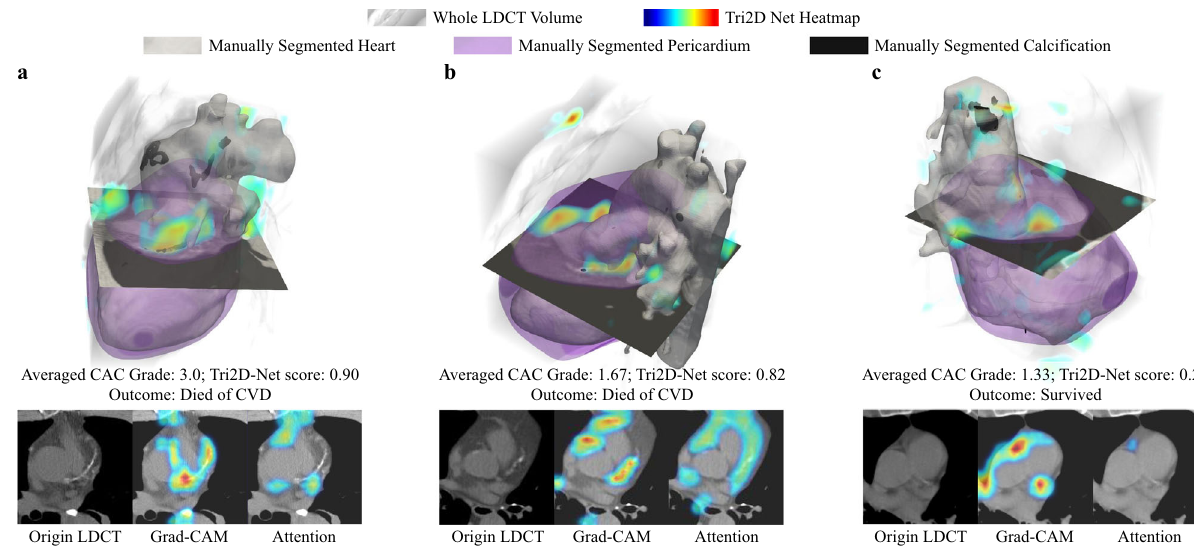
Fig. 5 Visualizations of the features learned by the Tri2D-Net. The Gradient-weighted Class Activation Mapping (Grad-CAM 37 ), and the attention maps of Case ( a ), Case ( b ), and Case ( c ) learned by the attention block in the Tri2D-Net are visualized with heatmaps. The Grad-CAM 37 is a widely used visualization technique for CNN that produces a coarse localization map highlighting the important regions in the image for the fi nal